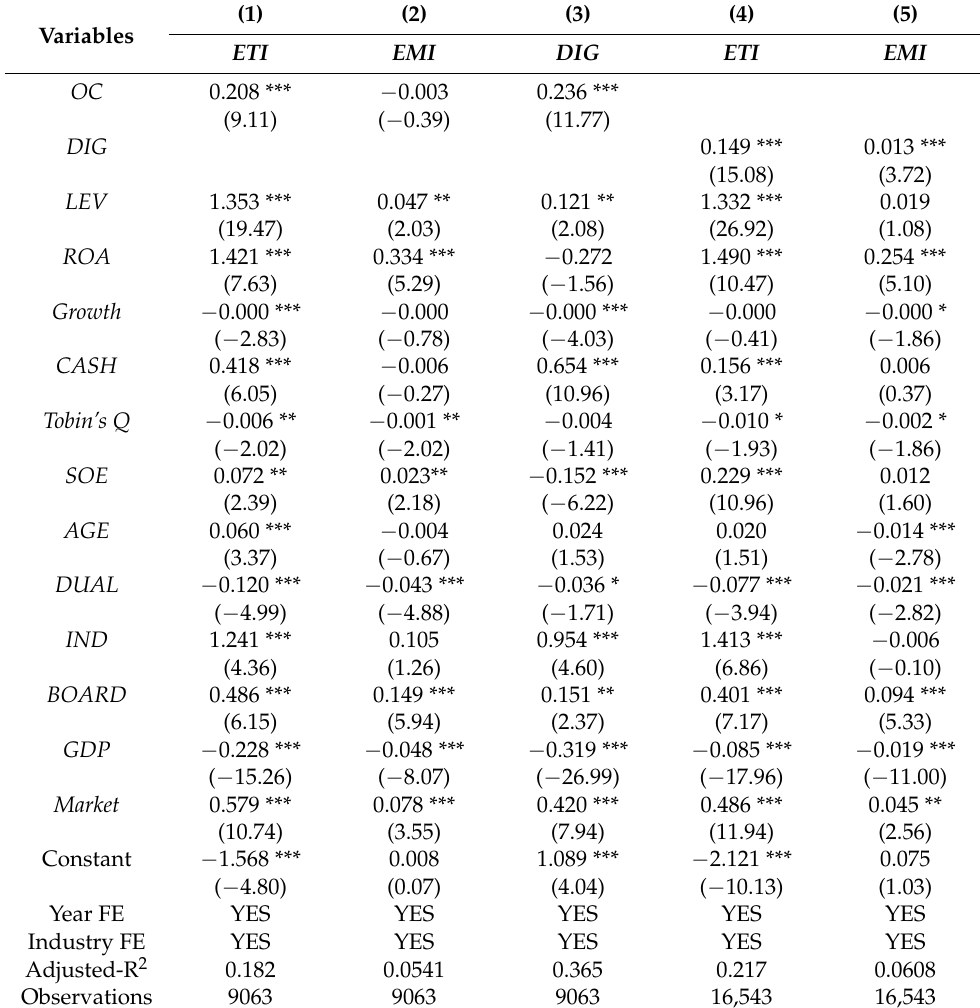
Table 5. Endogenous test of propensity score